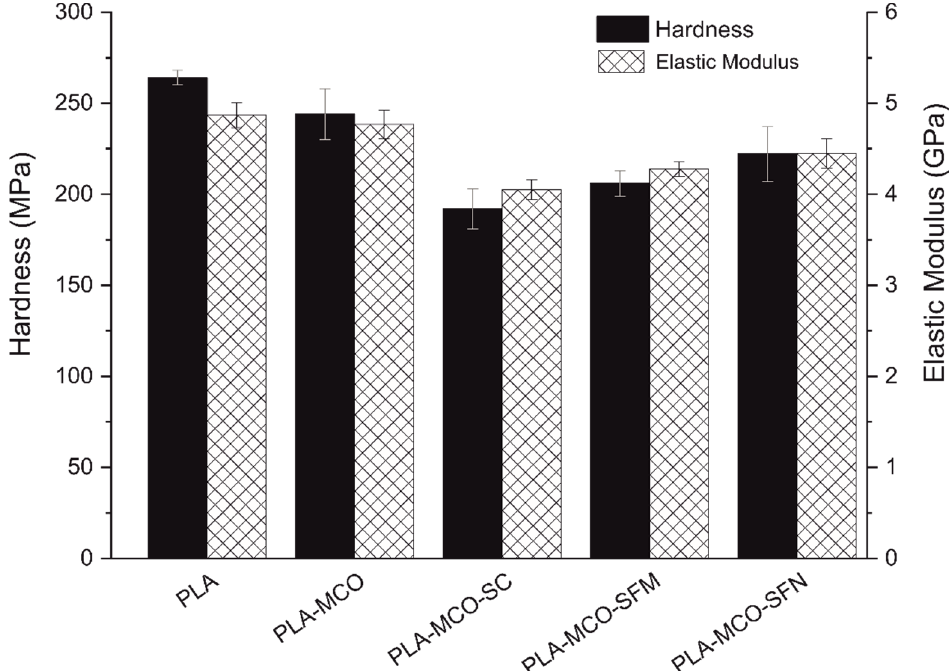
Figure 4. Hardness and elastic modulus acquired for each formulation by nanoindentation technique.